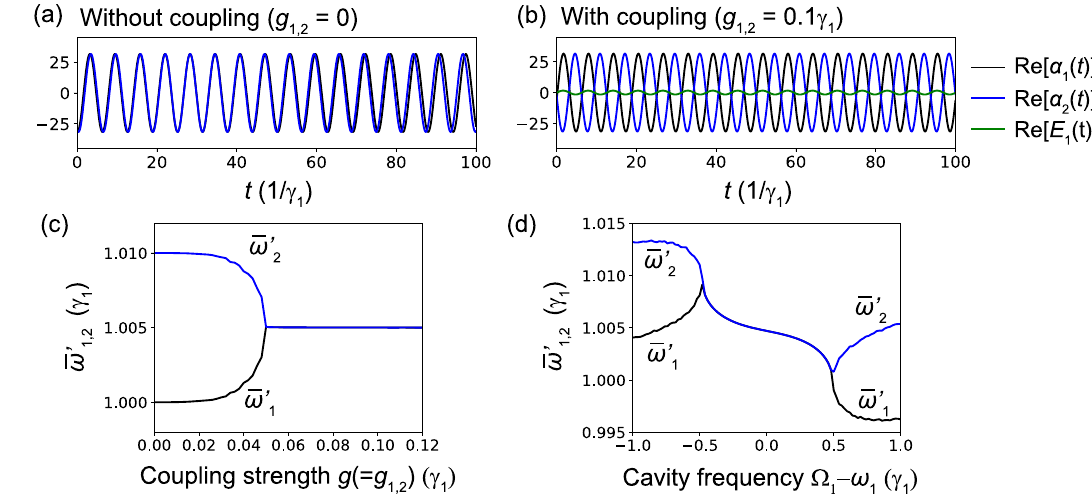
Figure 2. Simulations for two lasers [see Fig. 1b] coupled via a cold cavity. The simulated time evolutions of the real part of the field Re [ α 1,2 ( t ) ] without g 1,2 = 0 ( a ) and with coupling g 1,2 = 0.1 γ 1 (b). Here, we used the shifted laser and cold cavity frequencies ω ′ 1 = 1 γ 1 , ω ′ 2 = 1.01 γ 1 , � ′ 1 = 1 γ 1 . In ( b ), we also show the time evolution of the real part of the field of the cold cavity Re [ E 1 ( t ) ] . ( c ) Mean frequency of the laser oscillation ¯ ω 1,2 as a function of coupled strength g 1,2 . ( d ) Mean frequency ¯ ω 1,2 for fixed coupling strength ( g 1,2 = 0.1 γ 1 ) but as a function of the resonance frequency of the cold cavity (cid:31) 1 , which tunes the effective coupling strength between the two